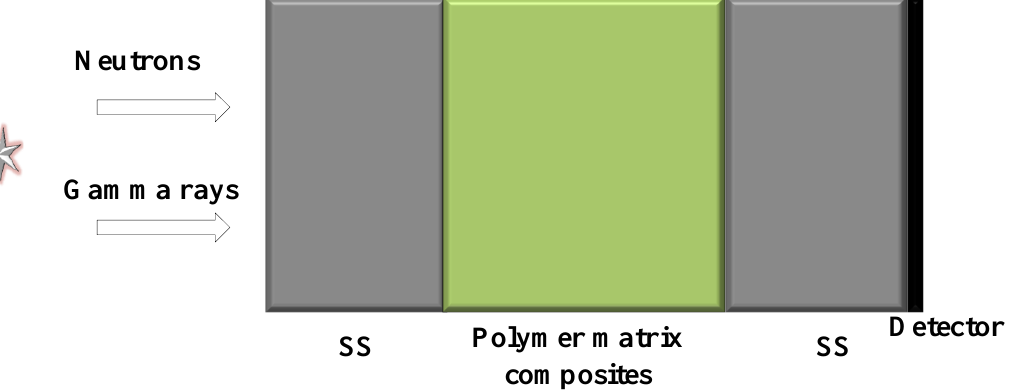
Figure 1. Multilayer structural material containing a polymer-based interlayer.